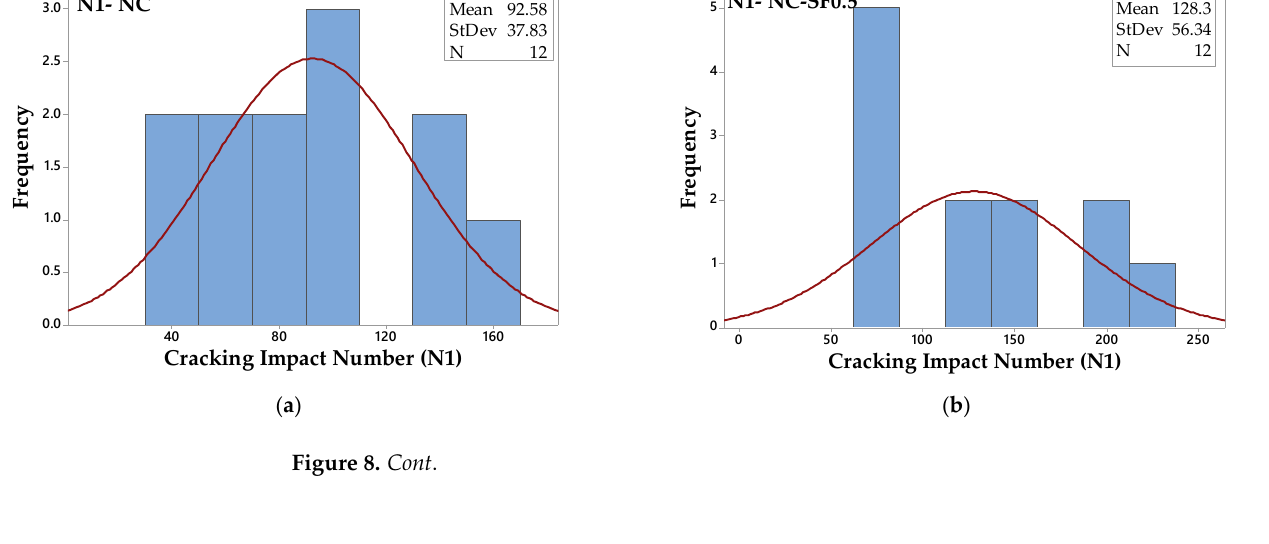
( d ) Figure 8. Distributions of results at the cracking stage for mixtures ( a ) NC ( b ) NC-SF0.5 ( c ) NC-SF1.0 and ( d ) HC.